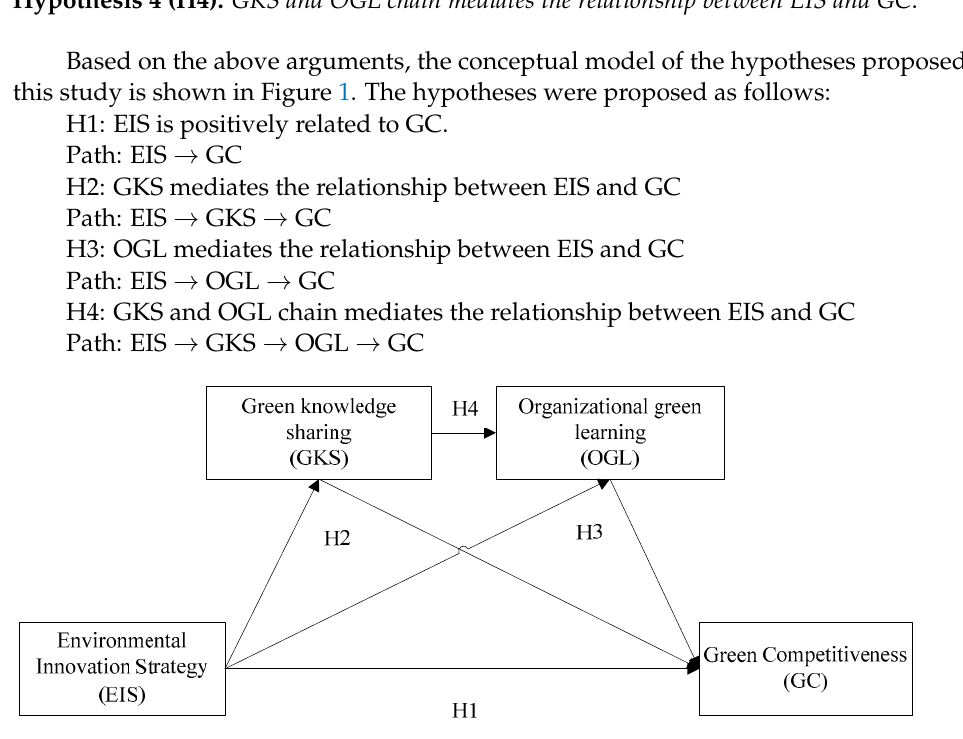
Figure 1. Hypothesized conceptual model.